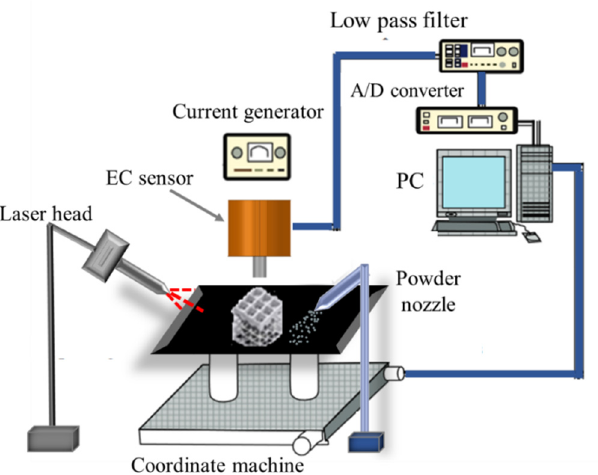
Figure 6. Schematic diagram of the defect detection and measurements during PBF process.